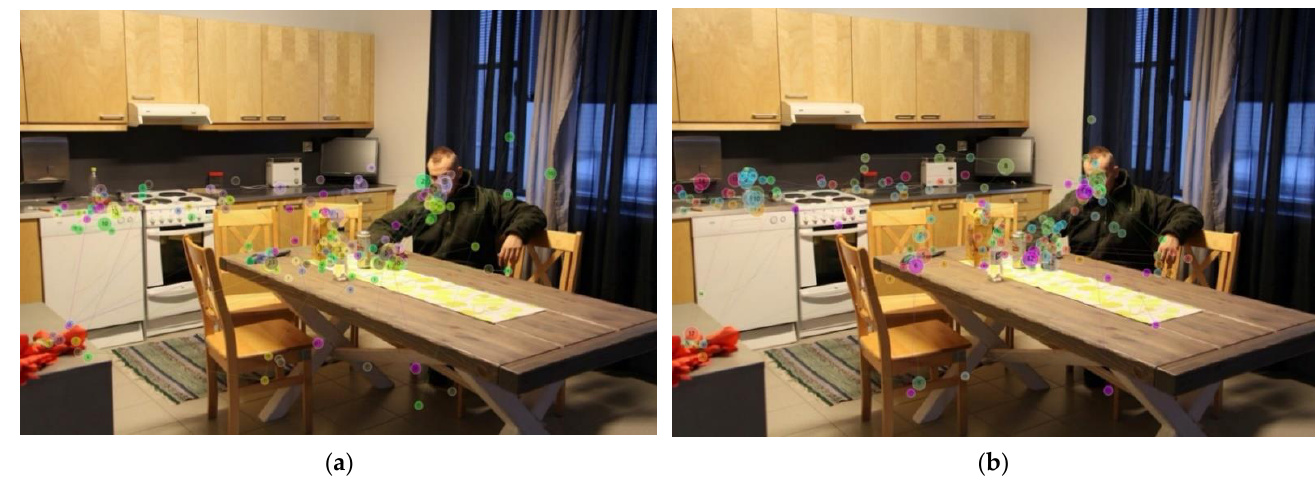
Figure 2. Sample eye tracking data. In both images, each individual circle represents a participant’s point of fixation. The size of each circle represents visit duration, with larger circles representing longer durations. The number within each circle represents the order of fixation following stimulus onset. The color of each circle corresponds to a specific participant: ( a ) Visualized eye tracking data for Novice 1 participants; ( b ) Visualized eye tracking data for expert